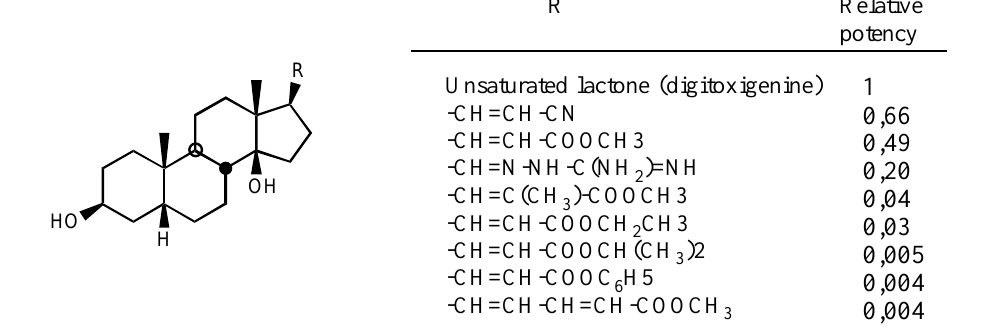
Figure 12. Structure and relative potency of some semisynthetic digitoxigenin derivatives, substituted at C17 b [67].